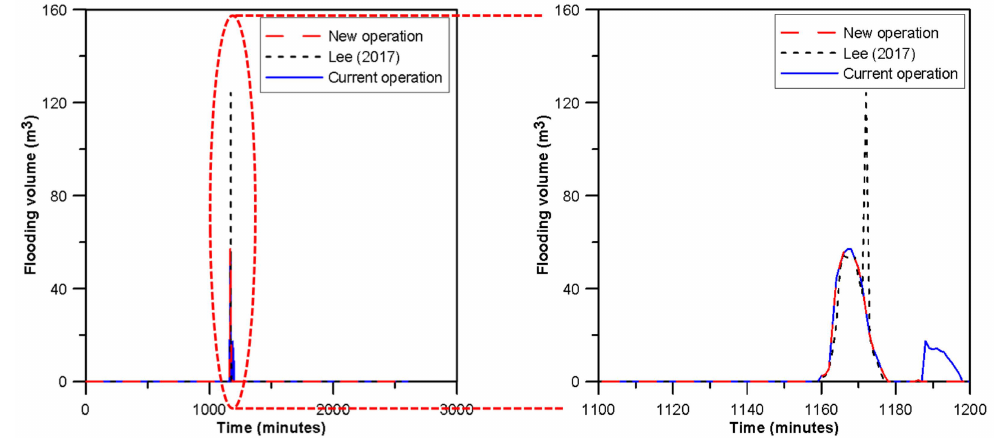
Figure 9. Flooding results of an advanced operation in 2011